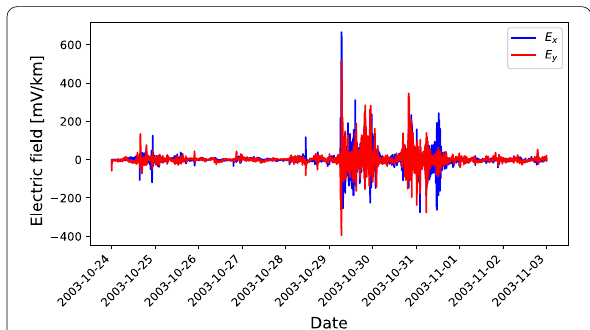
Fig. 3 The model for both horizontal components of the geoelectric field during the period of Halloween storms